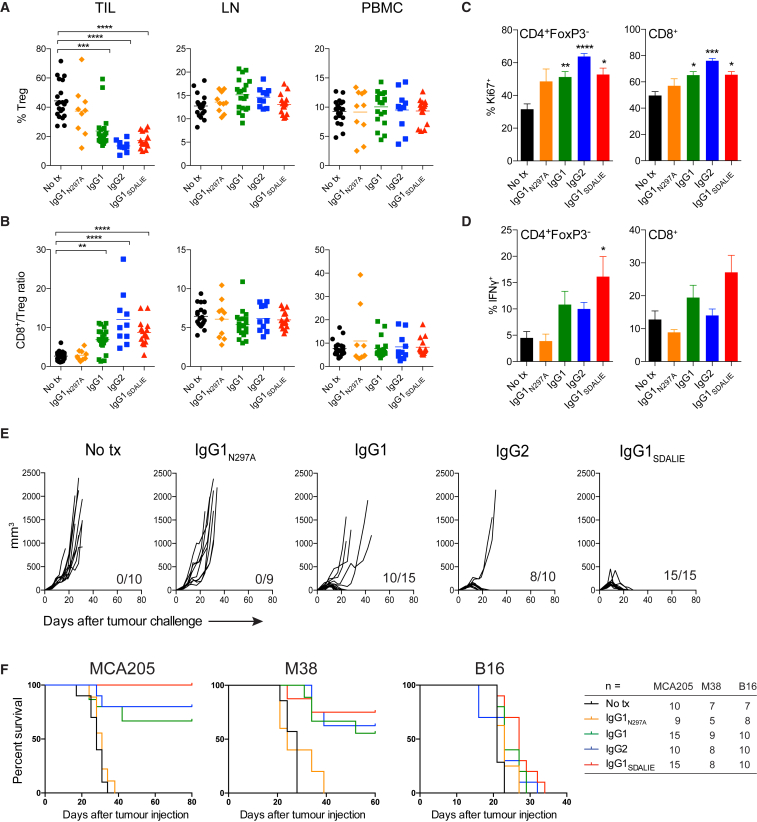
Intra-tumoral Treg Cell Depletion Is Required for the Anti-tumor Activity of Anti-CTLA-4Mice were treated with 200 μg of anti-CTLA-4 on days 6 and 9 after s.c. inoculation of MCA205 tumor cells (n = 9–21). TILs, LNs, and PBMCs were processed on day 11 and stained for flow cytometry analysis.(A) Percentage of FoxP3+CD4+ Treg cells from total CD4+ T cells.(B) CD8+/Treg cell ratio in the indicated sites. Horizontal bars represent the mean.(C) Percentage of Ki67-expressing CD4+FoxP3− and CD8+ T cells.(D) Percentage of CD4+FoxP3− and CD8+ T cells expressing IFNγ following re-stimulation with phorbol 12-myristate 13-acetate (PMA) and ionomycin; cumulative data of three separate experiments. Error bars show ±SEM.(E and F) hFcγR mice were treated with anti-CTLA-4 on days 6, 9, and 12 after s.c. inoculation of MCA205 (50 μg/dose), MC38 (100 μg/dose) or B16 (200 μg/dose) tumor cells. (E) MCA205 tumor growth in individual hFcγR mice in each treatment group. Inset numbers show the fraction of mice with complete long-term response. (F) Kaplan-Meier curves demonstrating survival of hFcγR mice for each tumor model. The total number of mice in each treatment group is shown at the right.∗p < 0.05; ∗∗p < 0.01; ∗∗∗p < 0.001; ∗∗∗∗p < 0.0001. See also Figure S4.